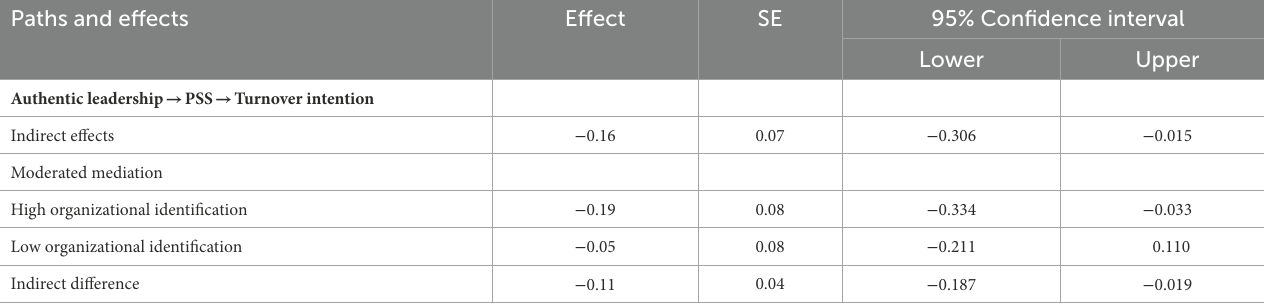
TABLE 5 Summary of indirect effects and conditional indirect